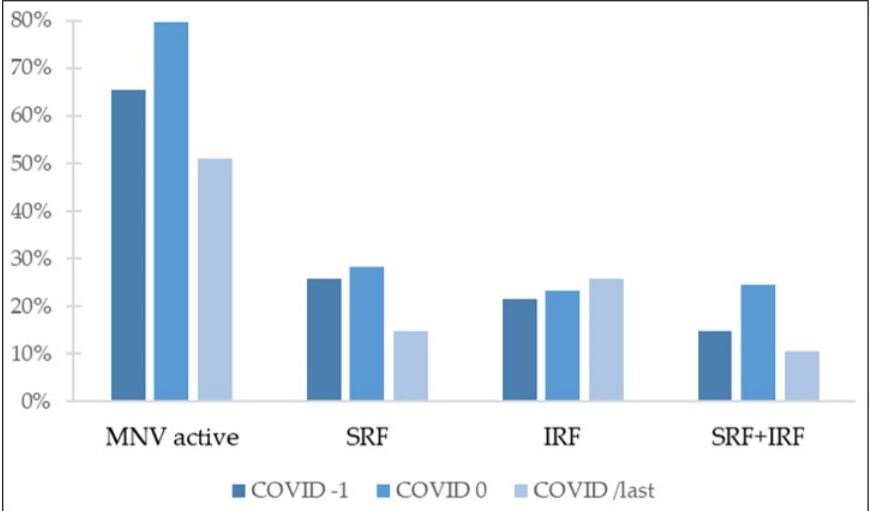
Figure 2. Percentage of eyes with different tomographic features. MNV: macular neovascularization; SRF: subretinal fluid; IRF: intraretinal fluid.